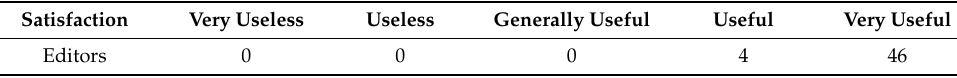
Table 8. The evaluation of the satisfaction of SpIn. Satisfaction Very Useless